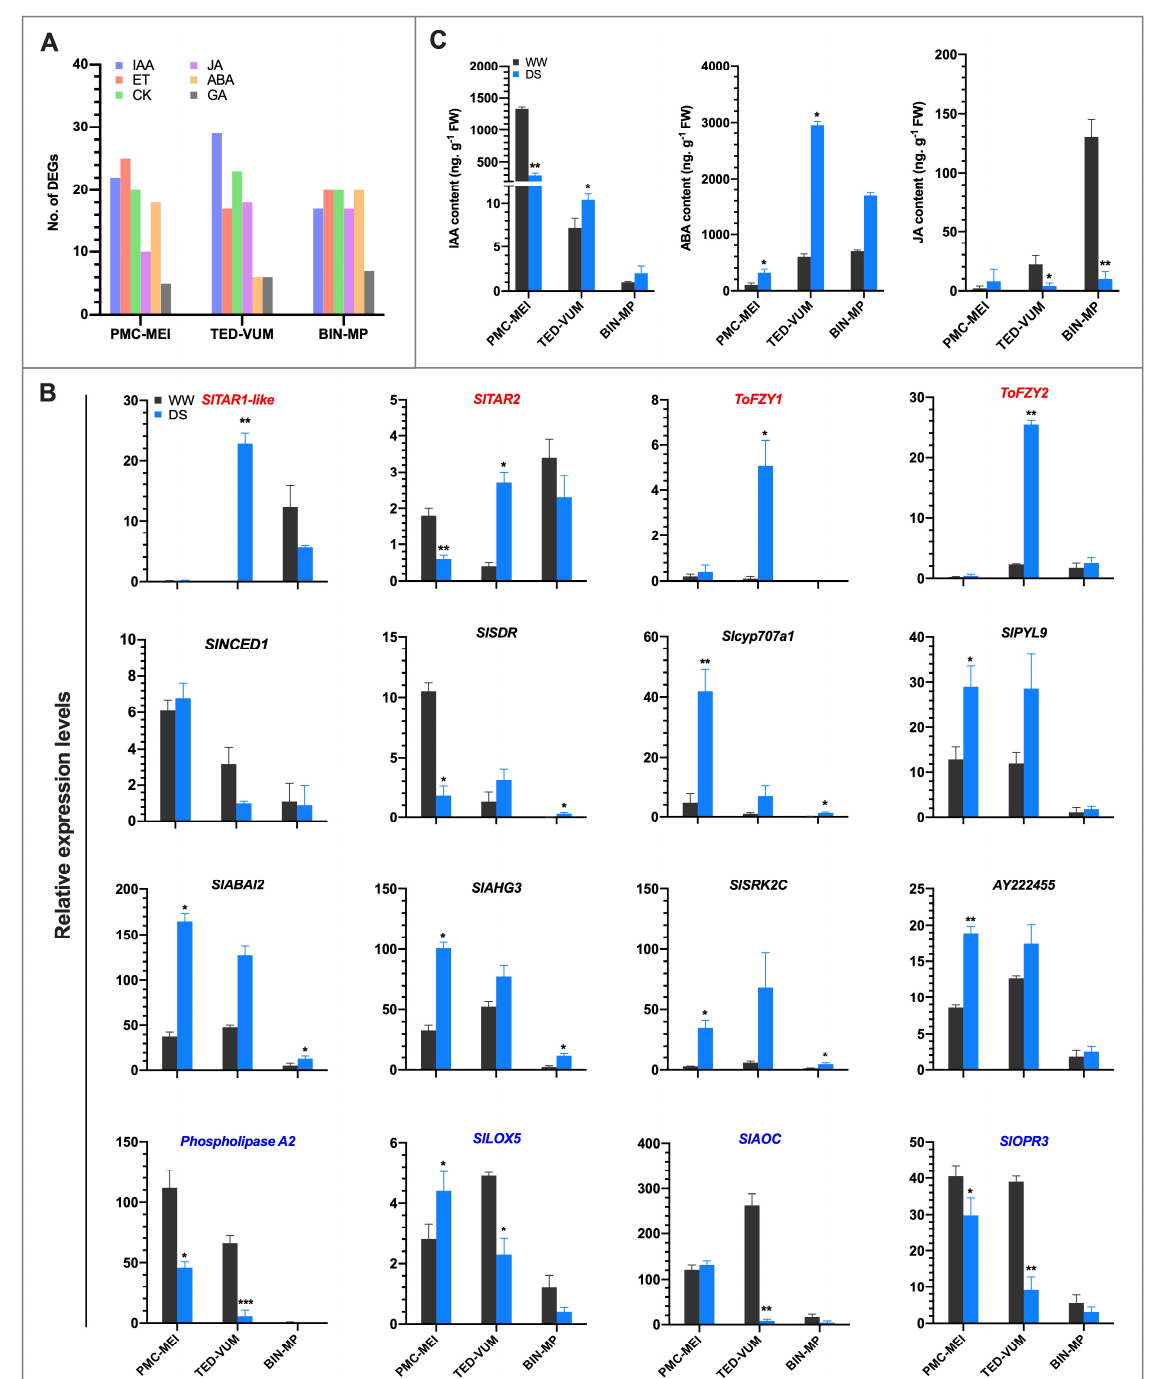
Figure 7. IAA, ABA and JA metabolisms and signaling in three groups of anthers of different developmental stages under drought stress in tomato. ( A ) Distribution (%) of different phytohormones metabolic and signaling DEGs in tomato anthers. ( B ) Expression analysis of genes involved in IAA (red titles), ABA (black titles) and JA (blue titles) metabolisms and/or signaling in DS anther. Gene expression levels were based on the number of fragments per kilobase of transcript sequence per millions (FPKM) base pairs sequenced from RNA-Seq data. ( C ) Contents of IAA, ABA and JA in anthers 4 days after DS. Values are means ±SD ( n = three replications, 24 plants each). * p < 0.05; ** p < 0.01; *** p < 0.001 ( t -test). A total of 19 DEGs associated with ABA metabolism and signaling were identified (Table S11). In the PMC-MEI anthers, Slcyp707a1, encoding ABA 8′-hydroxylase involved in ABA catabolism, was markedly up-regulated. The core components of ABA signaling